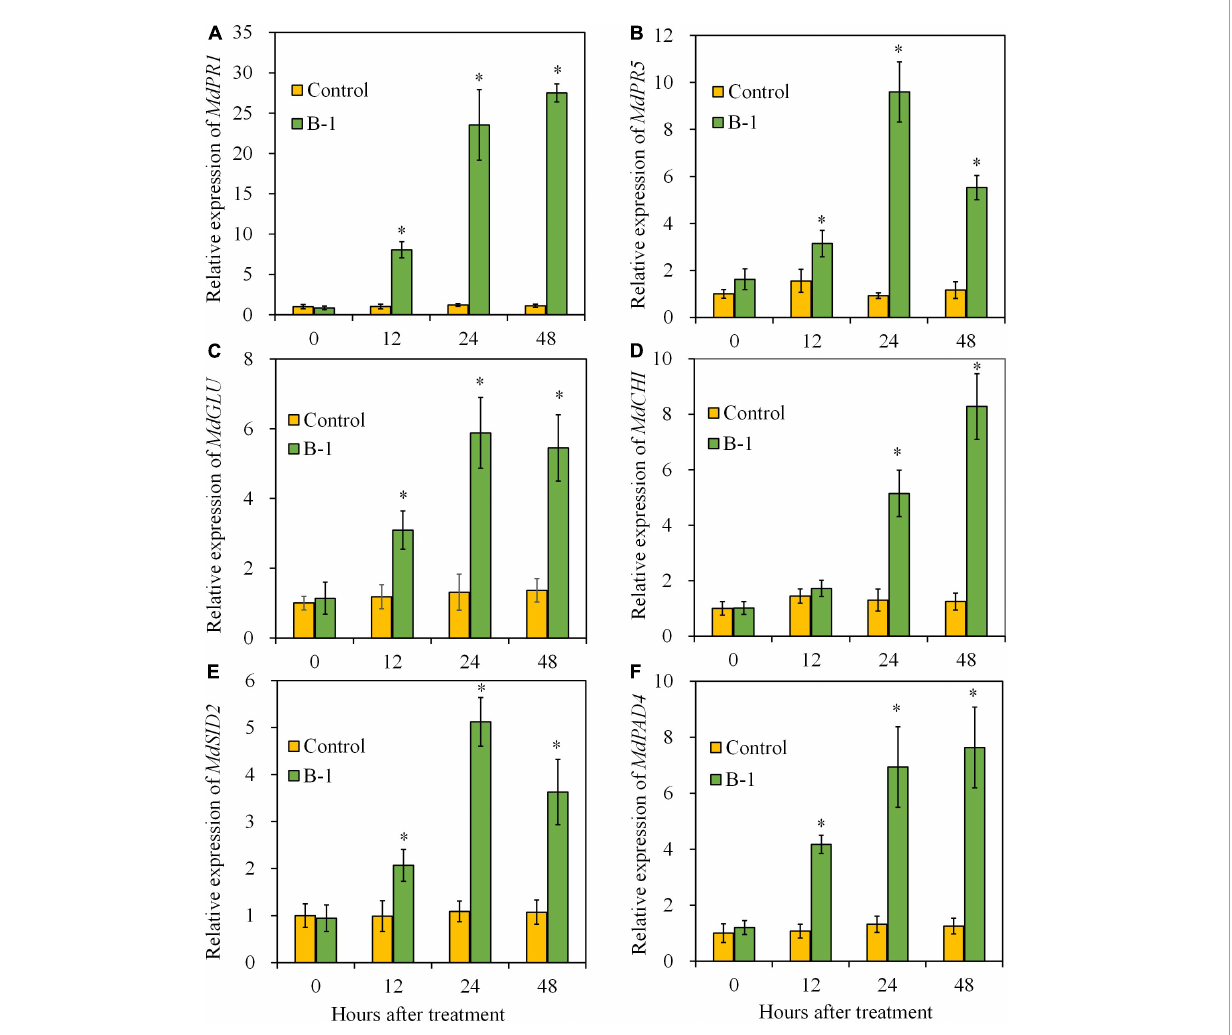
FIGURE9 The gene expressions of MdPR1 (A) , MdPR5 (B) , MdGLU (C) , MdCHI (D) , MdSID2 (E) , and MdPAD4 (F) in apple fruit treated with P. syringae B-1 at 1 × 10 8 CFU mL– 1 stored at 25 ◦ C. Each data represents the mean ± SD of three biological replicates. Asterisks ( ∗ ) denote a significant difference ( p < 0.05) between the strain B-1 treatment and the control apple fruit at the same time